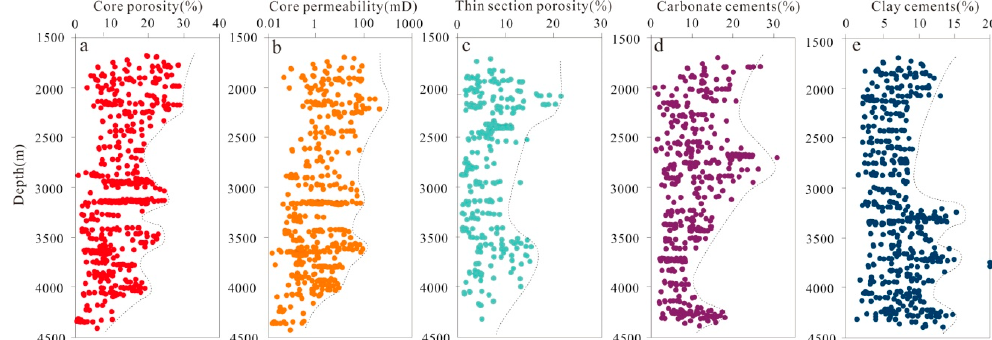
Figure 5. Plot showing variations of ( a ) core porosity; ( b )core permeability; ( c ) thin section porosity; ( d ) carbonate cement; ( e ) and clay cementswith respect to depth.